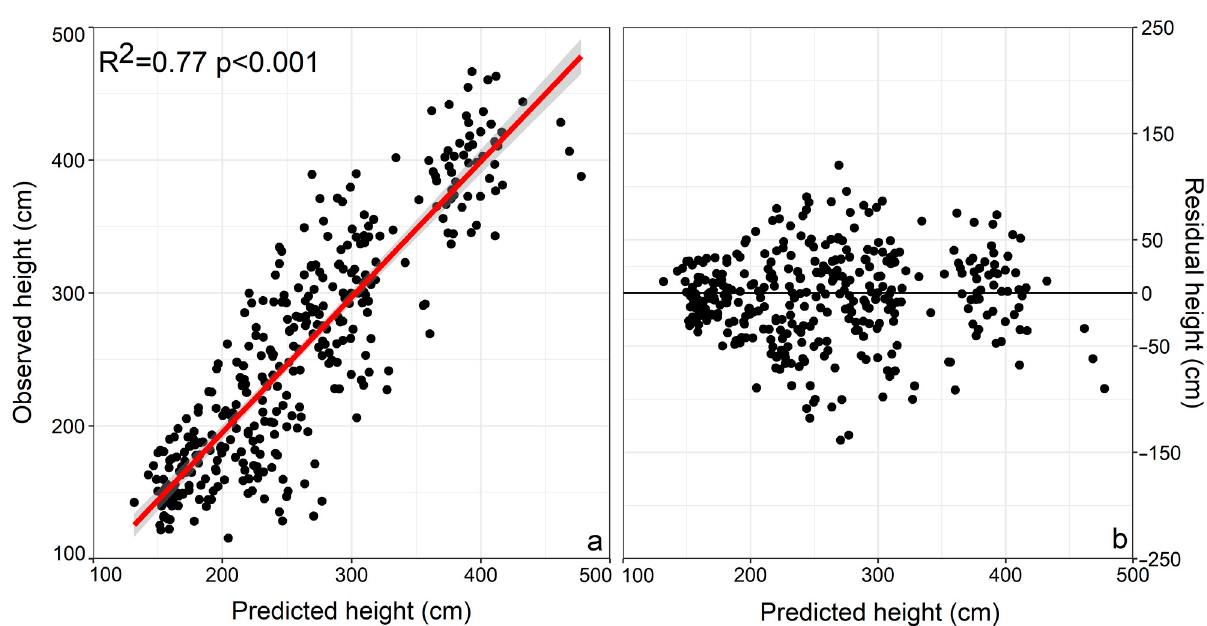
Figure 3. The comparison of observed and predicted values by the neural network model ( a ) and residual scatter plot ( b ).